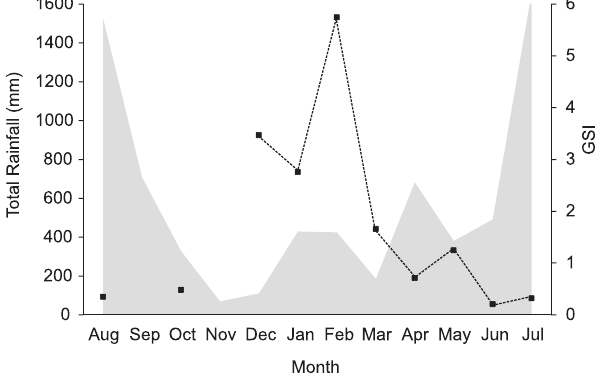
Figure 9. Regional total rainfall (shaded area) and GSI (dashed line) for females of S. herzbergii , between August 2009 and July 2010 in Paraíba do Norte River Estuary, Paraíba, Brazil (INPE/CPTEC 2012).